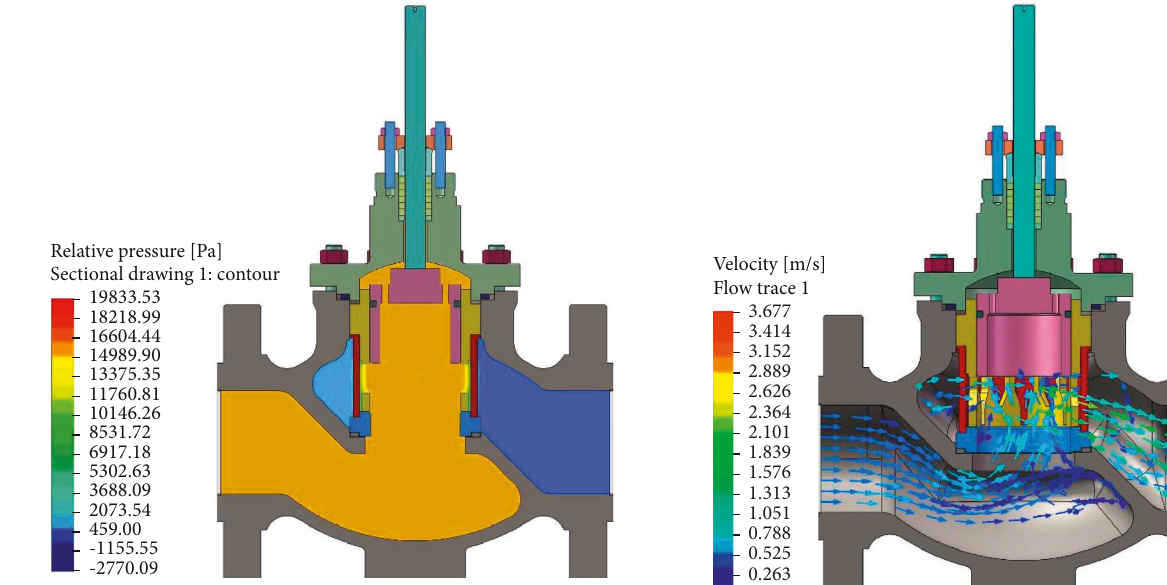
Figure 13: Pressure cloud map for 100% opening.